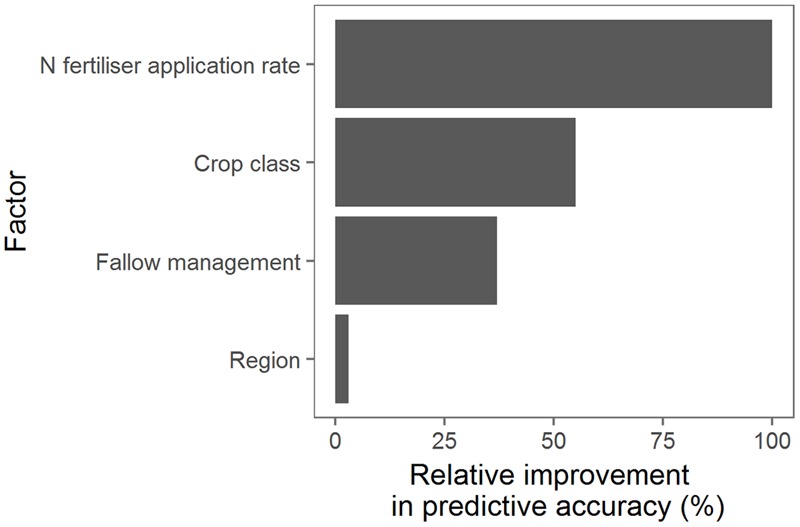
Ranking of factors (primary and surrogate) determining nitrogen use efficiency [Mg cane (kg N)-1] predicted for 6.9 million sugarcane crops simulated under a wide range of management practices, soils and climates over 84 years. The ranking of the factors was based on their improvement in predictive accuracy across the whole regression tree (Figure 9) and were ranked relative to the most influential factor. Only the four factors shown in this figure improved the predictive accuracy in the pruned regression tree.